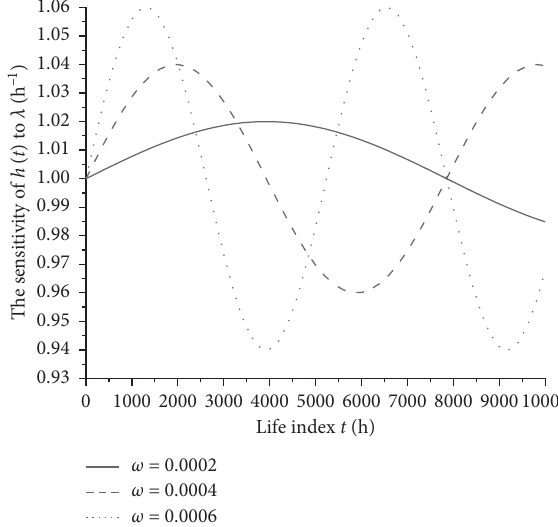
Figure 33: The sensitivity of h ( t ) to λ ( ω � 0.0002/0.0004/0.0006).